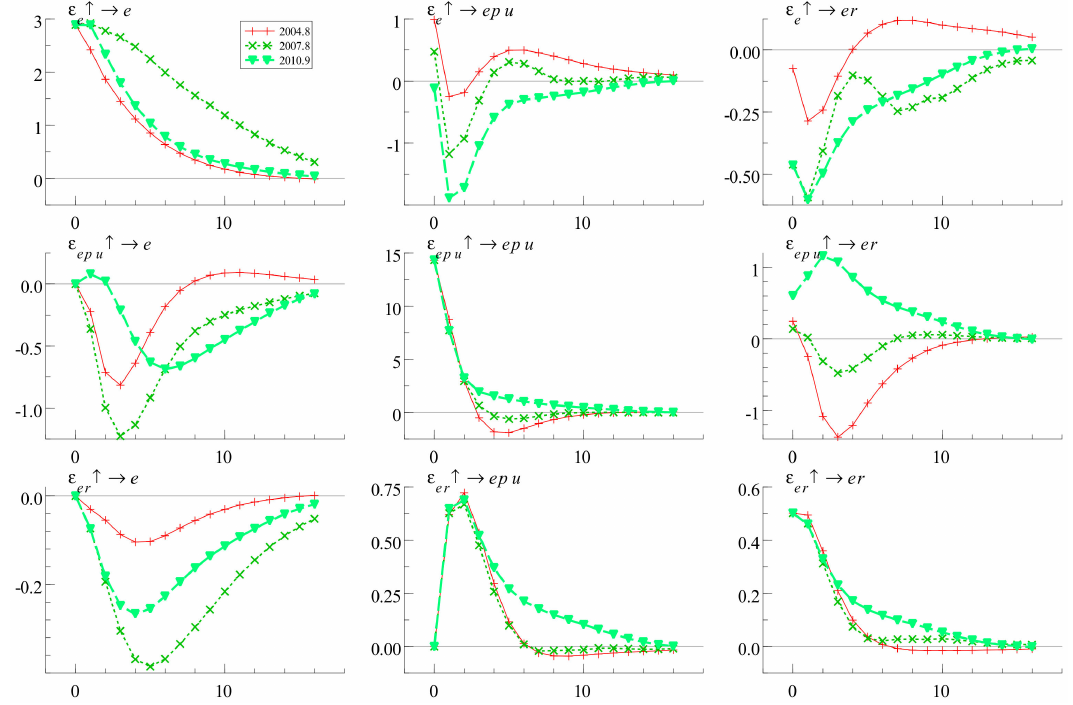
Figure 4. Time-varying impulse responses of the TVP-VAR model for structural breaks. Notes: 1. Horizontal axes indicate the number of months after a shock. 2. Vertical axes represent the standardized responses to shocks for each variable.